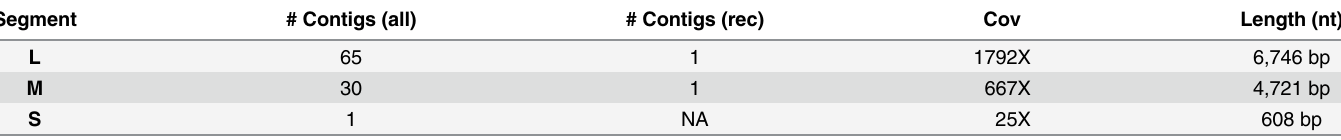
Table 1. Assembly statistics. ‘ all ’ indicates assembly generated from the full HiSeq dataset; ‘ rec ’ indicates assembly generated from the recruited subset; Cov indicates the combined coverage of each segment for both HiSeq runs.